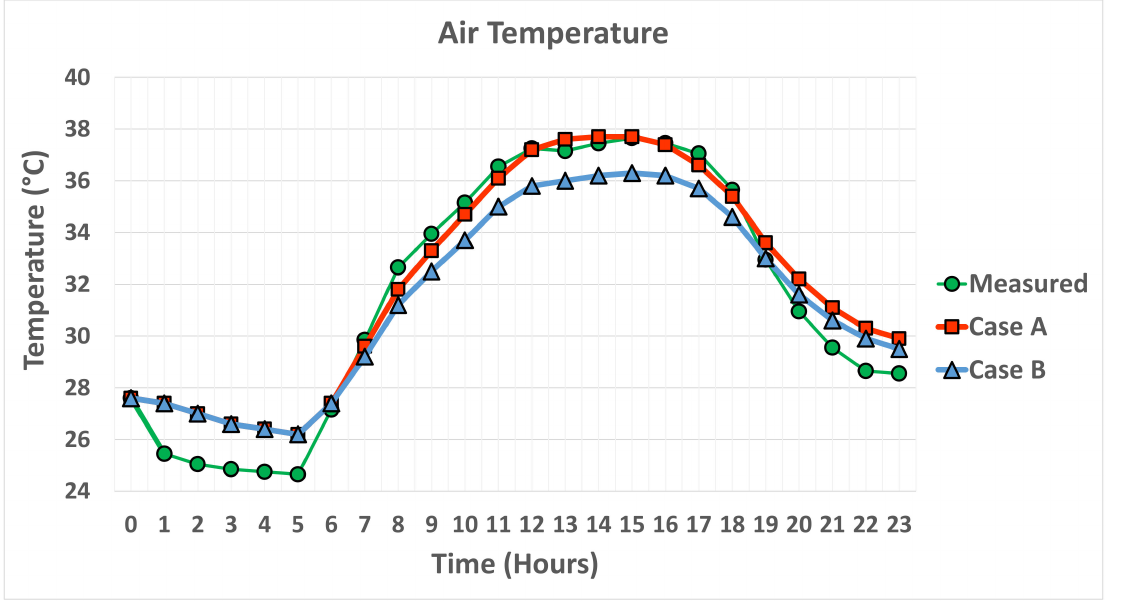
Figure 1. Measured (green graph with circular indicator) and calculated air temperature by the model for Case A (red graph with square indicator) and B (blue graph with triangular indicator) at 2 m height in correspondence with the centre of the